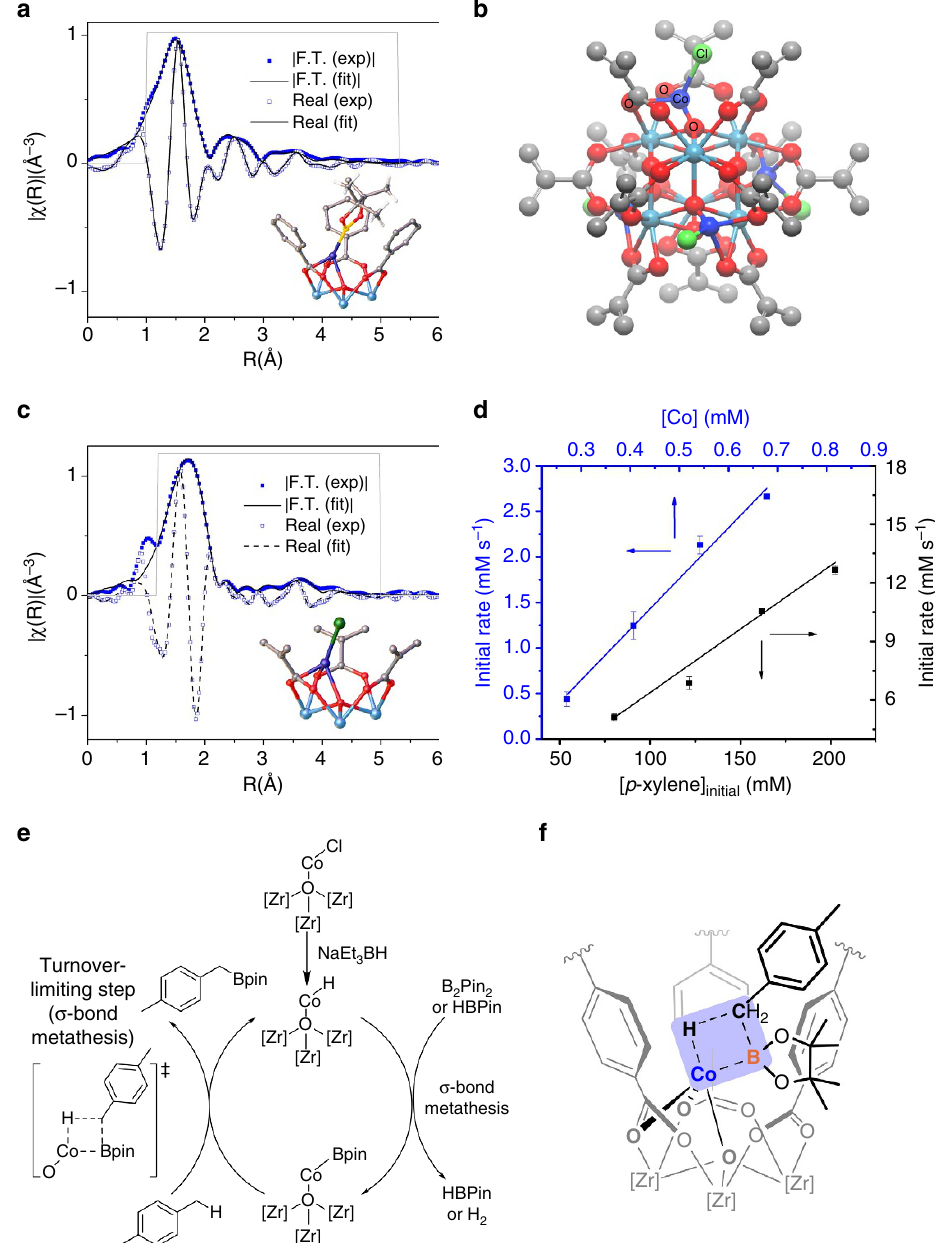
Figure 2 | Mechanistic study of Co@SBU catalysed reactions. ( a ) EXAFS spectra and the fits in R-space at the Co K-edge of UiO-68-CoBpin. Solid squares and solid line show the magnitude of of the Fourier transform whereas hollow squares and dashed line correspond to the real component (hollow squares, dashed line) of the Fourier transform. The fitting range is 1–5.3Å in R space (within the grey solid lines). ( b ) Structural model of homogeneous Zr 6 O 4 (OCoCl) 4 (McO) 12 cluster. ( c ) EXAFS spectra and the fits in R-space at the Co K-edge of Zr 6 O 4 (OCoCl) 4 (McO) 12 cluster. Solid squares and solid line show the magnitude of the Fourier transform whereas and real component (hollow squares and dashed line corespond to the real component of the Fourier transform. The fitting range of 1.18–4.98Å in R space (within the grey solid lines) is shown. ( d ) Kinetic plots of initial rates-(d[ p -xylene]/d t ) for benzylic C (cid:3) H borylation of p -xylene versus catalyst concentration and [ p -xylene] initial for the first 12h, showing the first-order dependence on both components. ( e ) According to the kinetic and experimental studies, UiO–Co-catalysed benzylic C (cid:3) H borylation of p -xylene likely proceeds via [2 s þ 2 s ] cycloaddition of ‘Co–Bpin’ bond with ‘H–CH 2 Ph’ bond of p -xylene as the turnover-limiting step. ( f ) Structural model showing the likely origin of chemoselectivity for C–H borylation reactions in the turnover-limiting